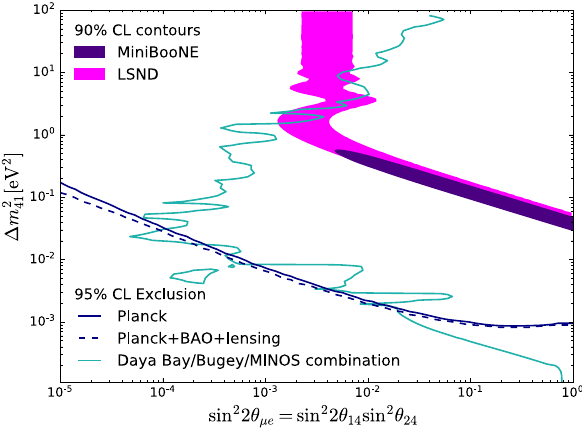
Fig. 4 Limits on the parameters governing ν μ → ν e appearance in a 3 + 1 model, shown in the neutrino-oscillation parameter space. Solid regions are the allowed regions from the MiniBooNE and LSND measurements. The light blue line is an exclusion region from the Daya Bay/Bugey/MINOS combined analysis. The dark blue lines show the Planck exclusion region, expressed in this parameter space, with (dashed) and without (solid) the BAO and CMB lensing data included